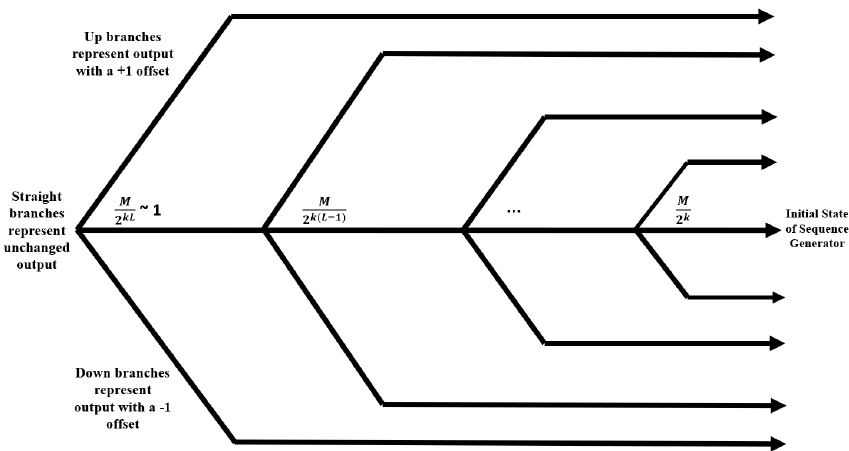
Figure 12. A communication system block diagram of the transmit-receive devices generating an RNS sequence and applying/removing noise to the outputs.